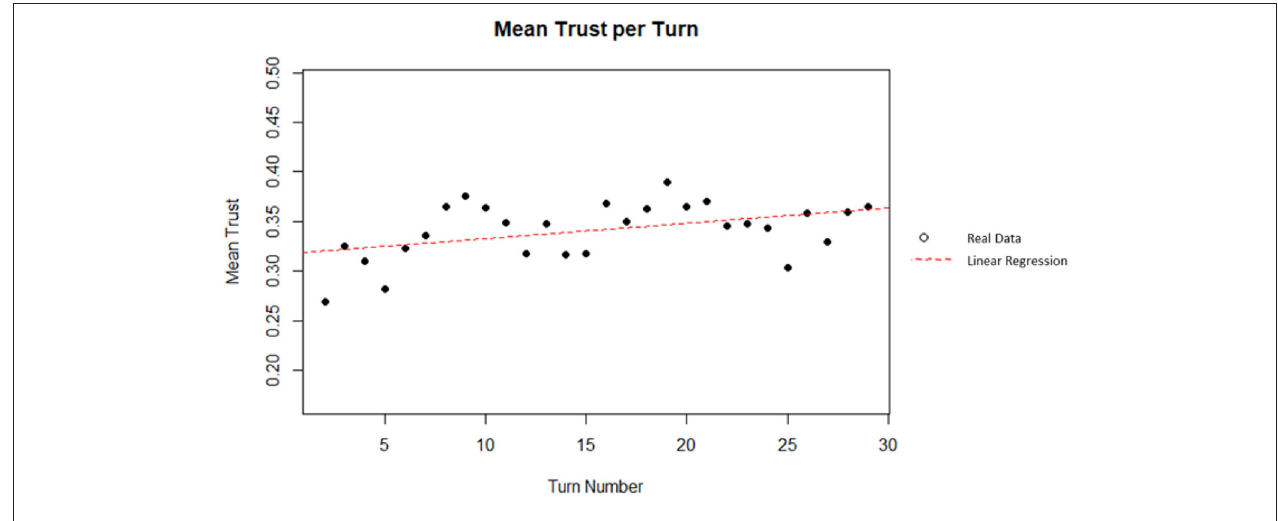
FIGURE 14 | Mean trust per turn.